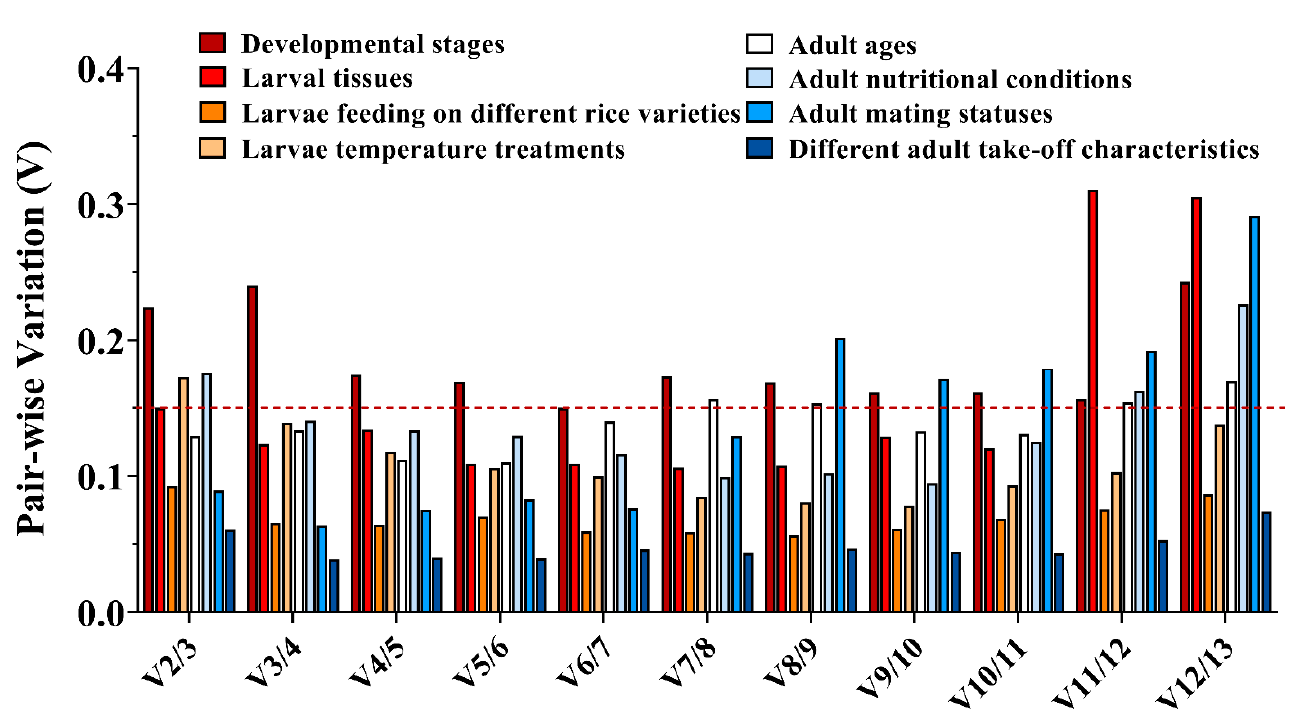
Figure 2. Expression stability of the candidate reference genes under eight experimental conditions calculated by RefFinder: ( A ): developmental stages; ( B ): larval tissues; ( C ): larvae feeding on differ- ent rice varieties; ( D ): larvae temperature treatments; ( E ): adult ages; ( F ): adult nutritional condi- tions; ( G ): adult mating statuses; ( H ): different adult take-off characteristics. A lower Geomean or- der indicated more stable expression.